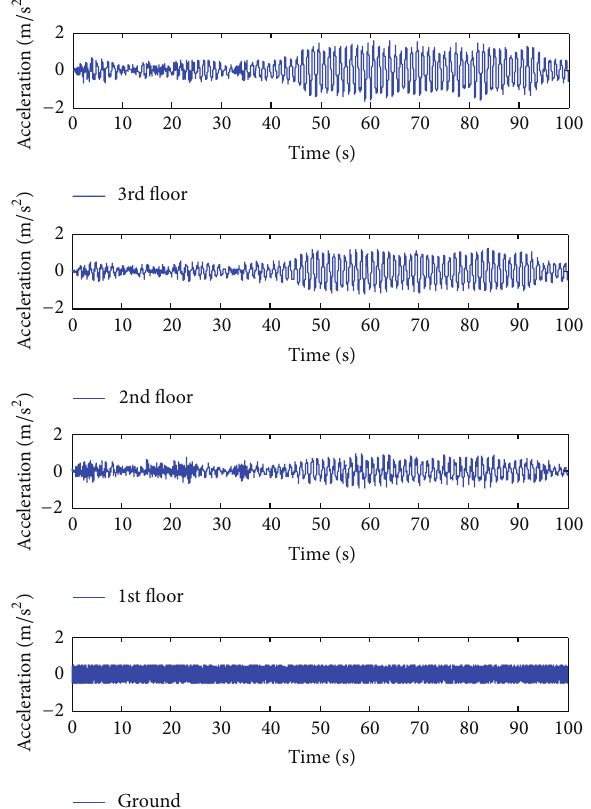
Figure1:Groundandnumericallycalculatedflooraccelerationtime histories of 3-story building.